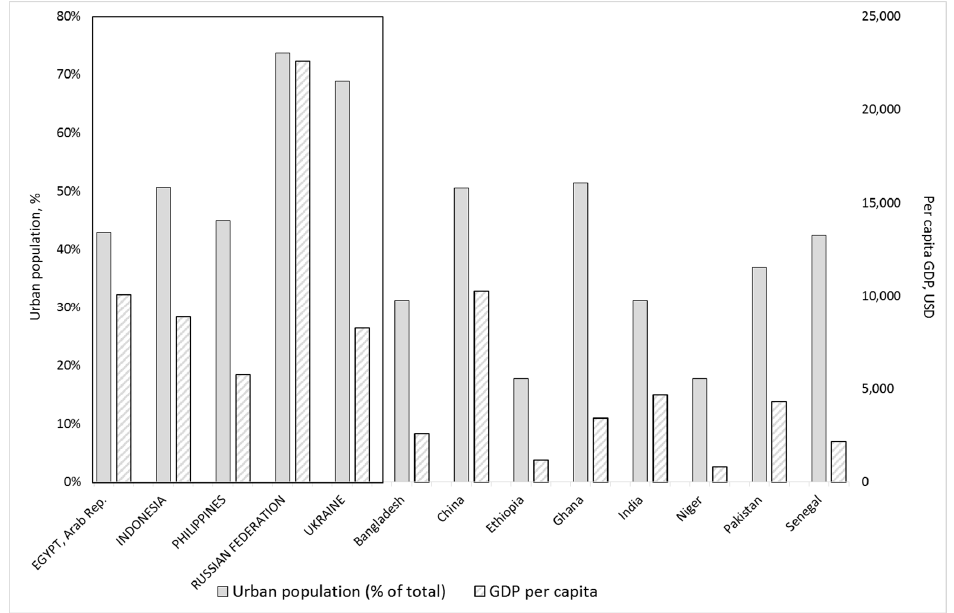
Figure 1. Percentage of population in urban areas (solid fill bars) and per capita gross domestic product (USD) (hashed fill bars) in the Partnership Project countries, 2011. The five countries for which case studies are presented in this paper are listed first and highlighted with a border.